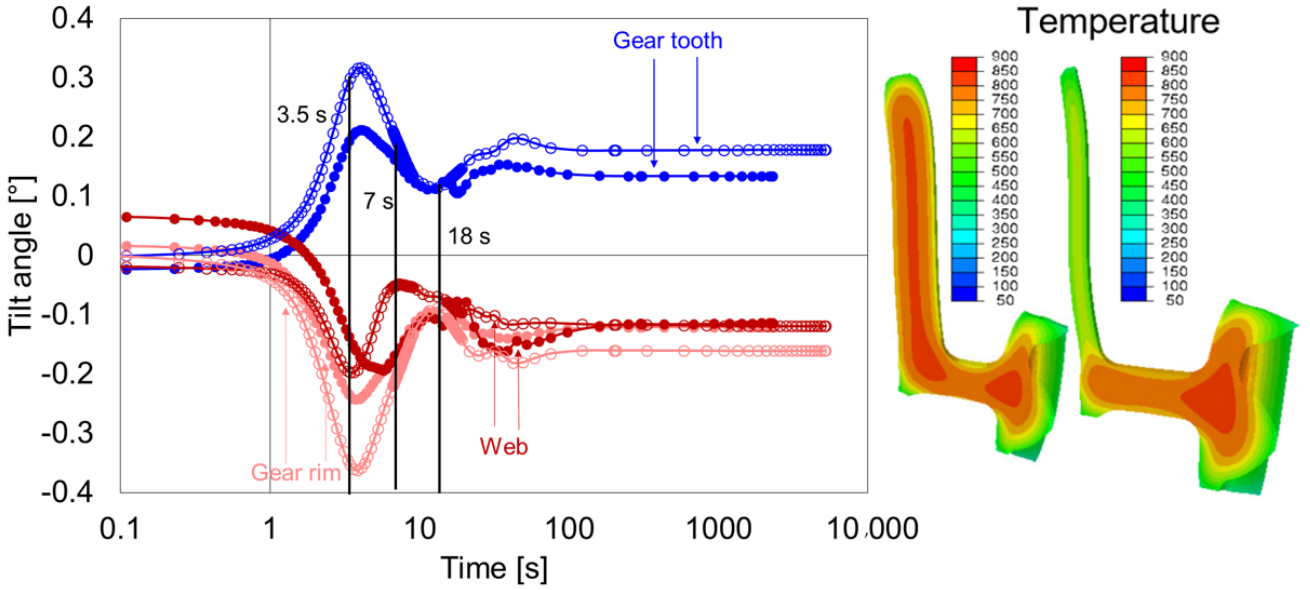
Figure 19. Tilt angle development of the web, gear rim, and gear tooth for the geometry type G4 (circle without fill) and comparison with geometry type G2 (circle with fill) during quenching ( left ), and temperature distribution and contour plot for G2 and G4 after 4 s ( right